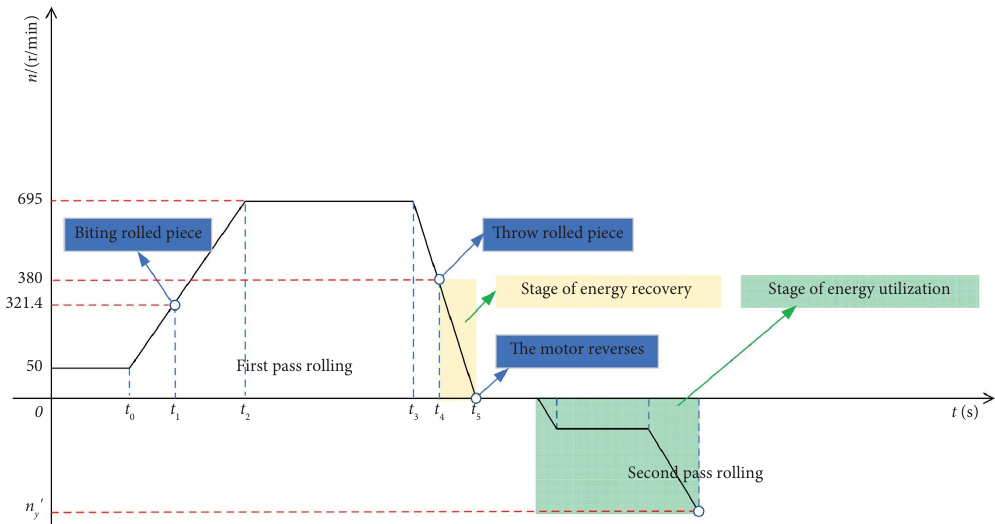
Figure 7: Working speed diagram of the reversible rolling mill